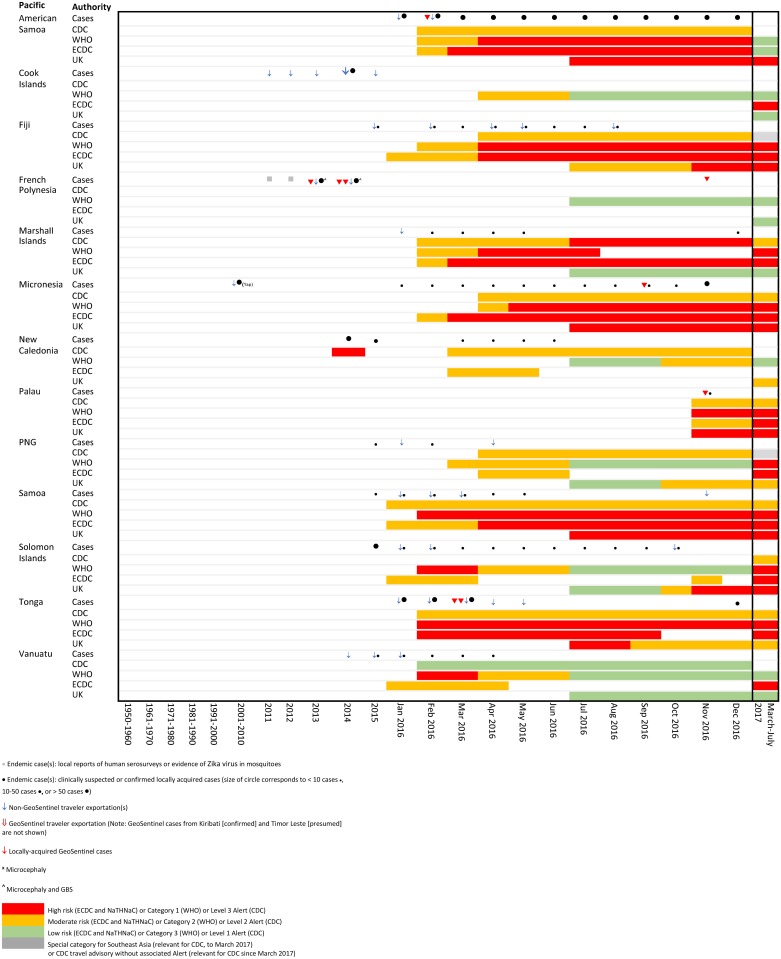
Temporal association of endemic and exported cases with travel notices by international authorities for selected countries in the Pacific.